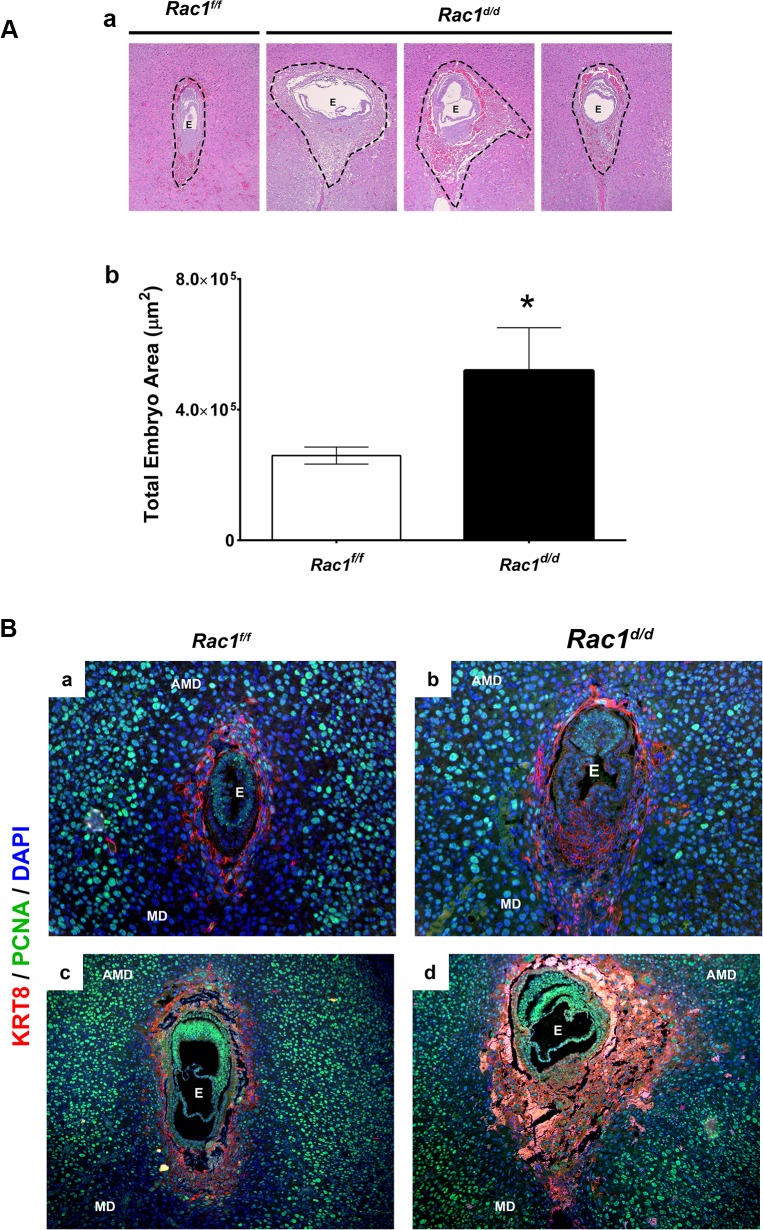
Enhanced trophoblast proliferation in Rac1 conditional-knockout mouse.
(A) Expanded trophoblast cells in Rac1d/d uteri on day 8 of gestation. a: Hematoxylin and Eosin (H & E) staining of uterine sections from Rac1
f/f and Rac1
d/d mice on day 8 of pregnancy. Three representative images of Rac1d/d uterine sections are shown. b: Quantitation of embryonic areas in H & E stained uterine sections of Rac1
f/f and Rac1
d/d mice on day 8 of pregnancy. Data represent mean ± SEM from six separate samples and were analyzed by non-parametric t-test. Asterisks indicate statistically significant differences (*P < 0.05). (B) Increased proliferation of trophoblast cells in the ectoplacental cone (EPC) of Rac1d/d uteri. Uterine sections from Rac1
f/f and Rac1
d/d mice on days 7 (panels a and b) and 8 of pregnancy (panels c and d) were subjected to IF using PCNA and cytokeratin 8 (KRT8) antibodies. AMD, MD, and E denote antimesometrial decidua, mesometrial decidua, and embryo respectively.